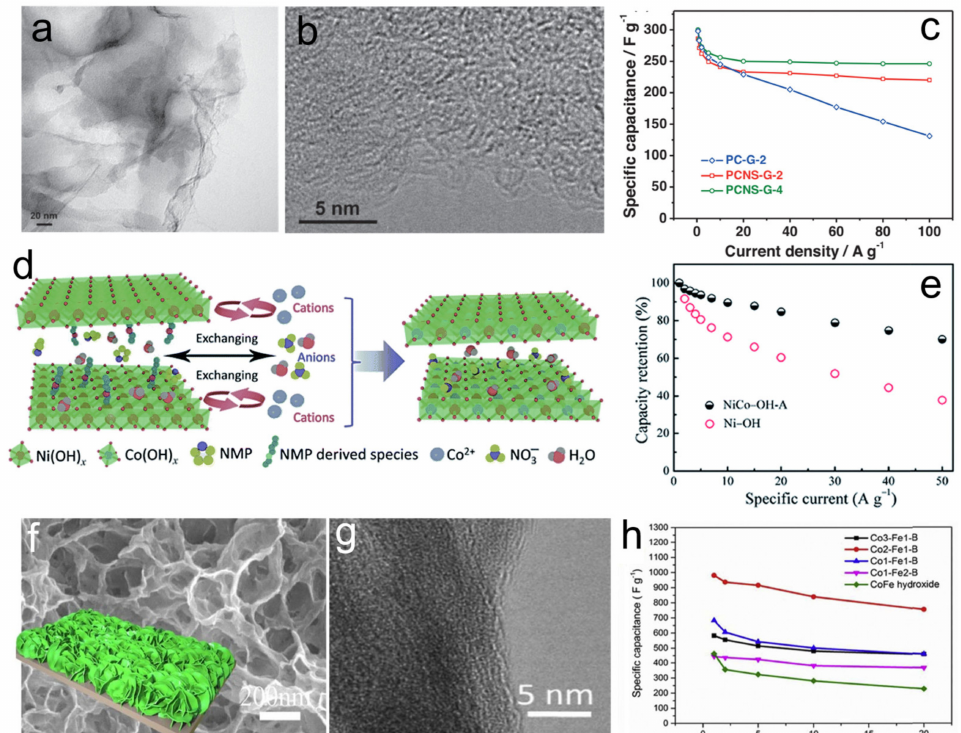
Figure 5. ( a ) TEM image of 2D porous carbon nanosheets; ( b ) HRTEM image of 2D porous carbon nanosheets; ( c ) Specific capacitances of 2D porous carbon nanosheets at different current densities. Reprinted with permission from Ref. [57]. Copyright Wiley-VCH, 2015. ( d ) Schematic diagram of the mechanism for ion exchange reactions; ( e ) Rate performance of amorphous Ni–Co hydroxide nanosheets. Reprinted with permission from Ref. [58]. Copyright Royal Society of Chemistry, 2018. ( f ) FESEM image and schematic illustration of the microstructure of NiCoMn–OH on Ni foams. Reprinted with permission from Ref. [60]. Copyright Elsevier, 2019. ( g ) HRTEM of the Co 0.2 Ni 0.8 pyrophosphate nanosheets. ( h ) The cycling performance at the current density of 1.5 A g − 1 for the Co 0.2 Ni 0.8 pyrophosphate and Co 0.2 Ni 0.8 NH 4 PO 4 · H 2 O precursor. Reprinted with permission from Ref. [61]. Copyright Elsevier,